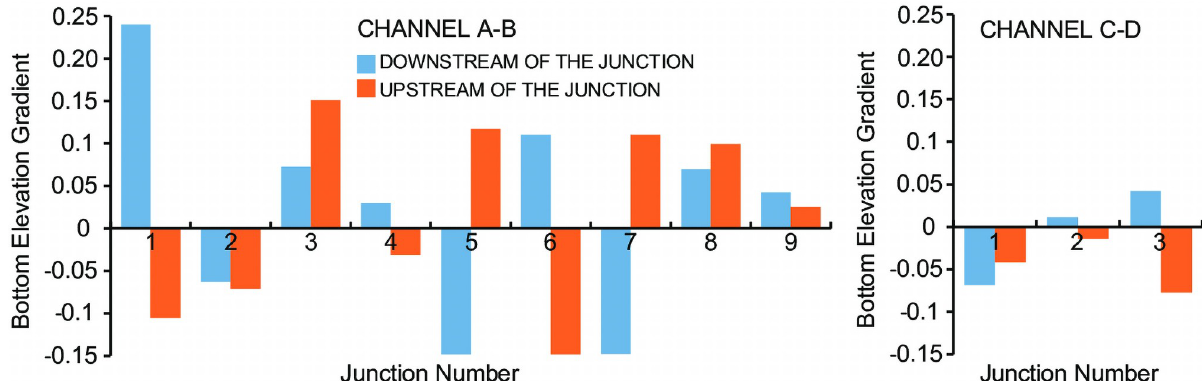
Fig 12. Bottom elevation gradient before and after each junction for channels A-B and C-D in Fig 1. The numbers refer to lateral tributaries discharging in the main trunk. Negative is defined as